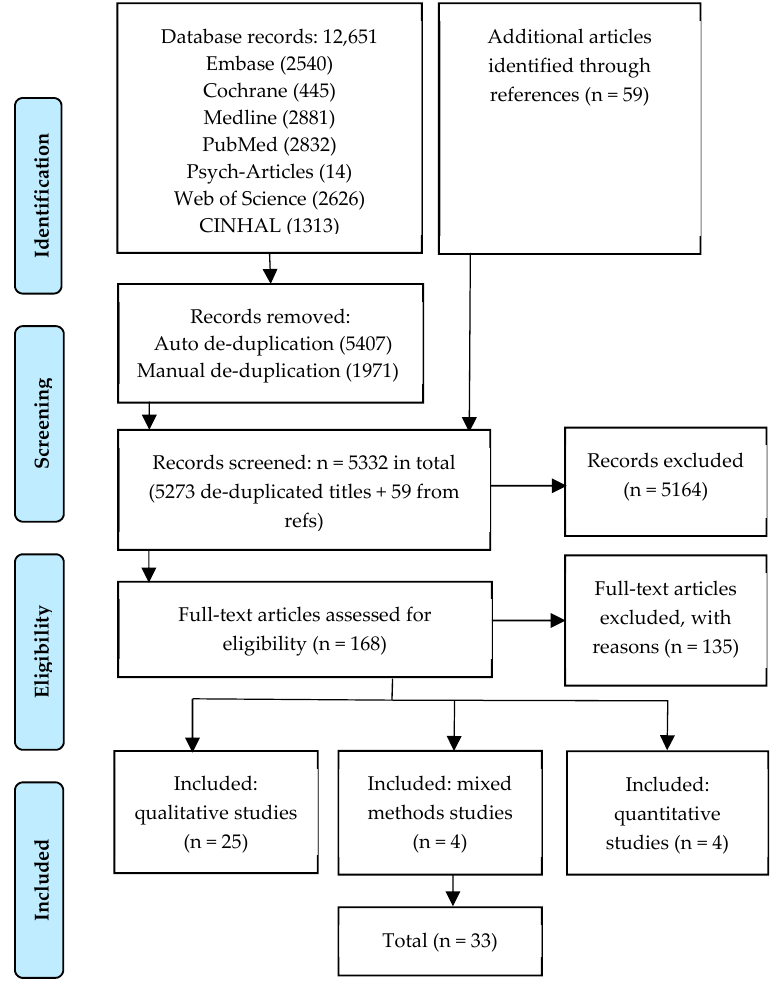
Figure 3. PRISMA flowchart.